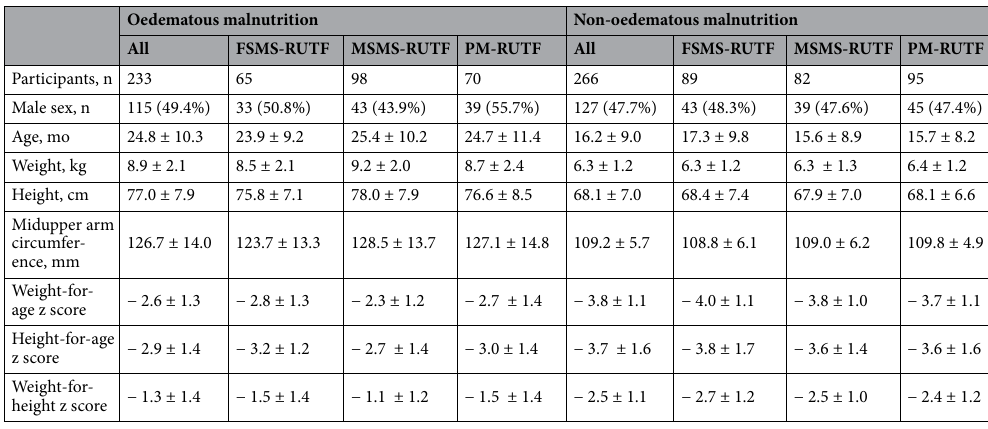
Table 1. Baseline characteristics of children . Values are expressed as n (%) or means ± SDs unless otherwise indicated.